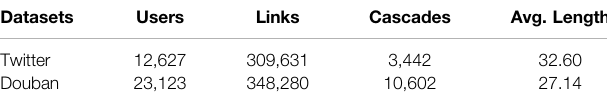
TABLE 1 | Statistics of